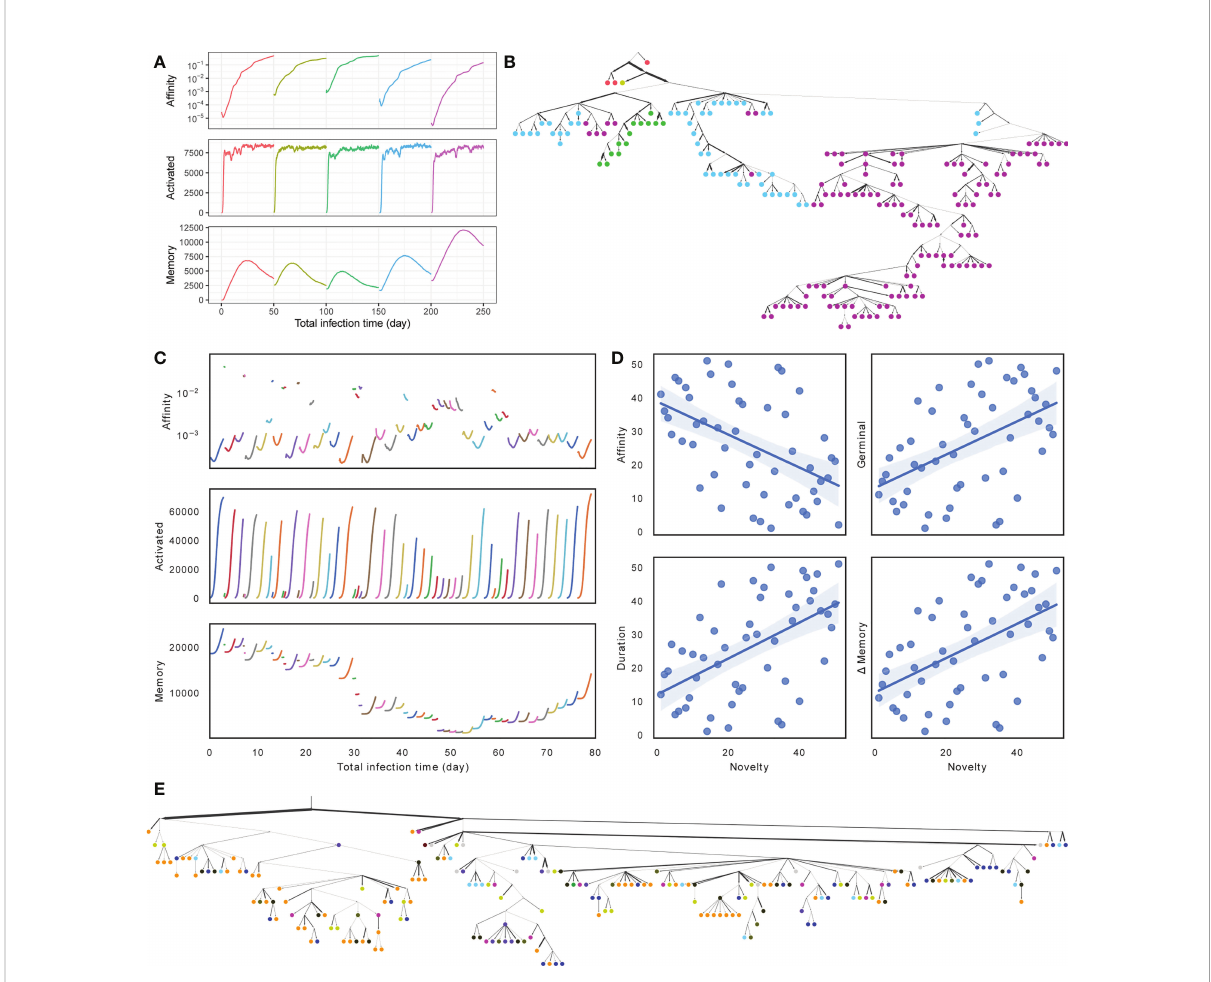
FIGURE 3 (A, C) Average af fi nity of activated cells to current infection target (log scale), the number of activated cells, and the number of memory cells by total time in infected stage across stages of infection (colors) for (A) SARS-Cov2 (discarding dormant stages) and (C) Flu (discarding the fi rst 5 rounds and dormant stages). (B, E) Clonal tree of memory cells sampled from one simulation under default condition after all rounds for (B) SARS-Cov2 and (E) Flu. Nodes are colored by rounds when the memory cells emerge (A, C) (in Flu tree, gray color is used for rounds 1 through 46). Here, 11 internal nodes in SARS-CoV2 tree and 17 internal nodes in Flu tree are sampled and are indicated as circles. Edge weights denote the number of mutations of sequences denoted by adjacent nodes. (D) Impact of the novelty of the antigen on the outcome of the infection across the 56 rounds of in fl uenza simulations. The novelty of rounds is measured by − max j<i { D z more novel on the x axis. The y-axis shows ranking (from low to high) of average af fi nity of activated cells to the current infection target ( R 2 = 0.242, p = 2.5 × 10 − 4 ) at the end of the infection, the number of activated cells ( R 2 = 0.248, p = 2.0 × 10 − 4 ) at the end of the infection, the duration of infection ( R 2 = 0.288, p = 4.8 × 10 − 5 ), and the change in memory cell count ( R 2 = 0.264, p = 1.2 x 10 − 4 ) from the start to the end of the infection. See Figure S1 for more